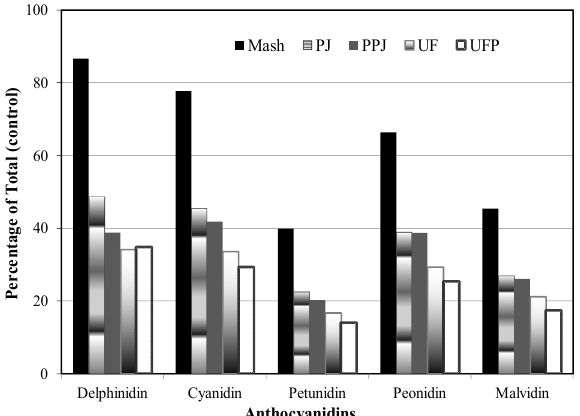
Figure 5. Percentage of control of anthocyanidins in rabbiteye blueberry juice processing steps. Mash = crude mash following the steam-jacketed kettle (prior to enzyme treatment and hydraulic pressing); PJ = pressed not filtered juice; PPJ = pasteurized pressed unfiltered juice; UF = ultrafiltration-filtered juice; UFP = filtered pasteurized juice.